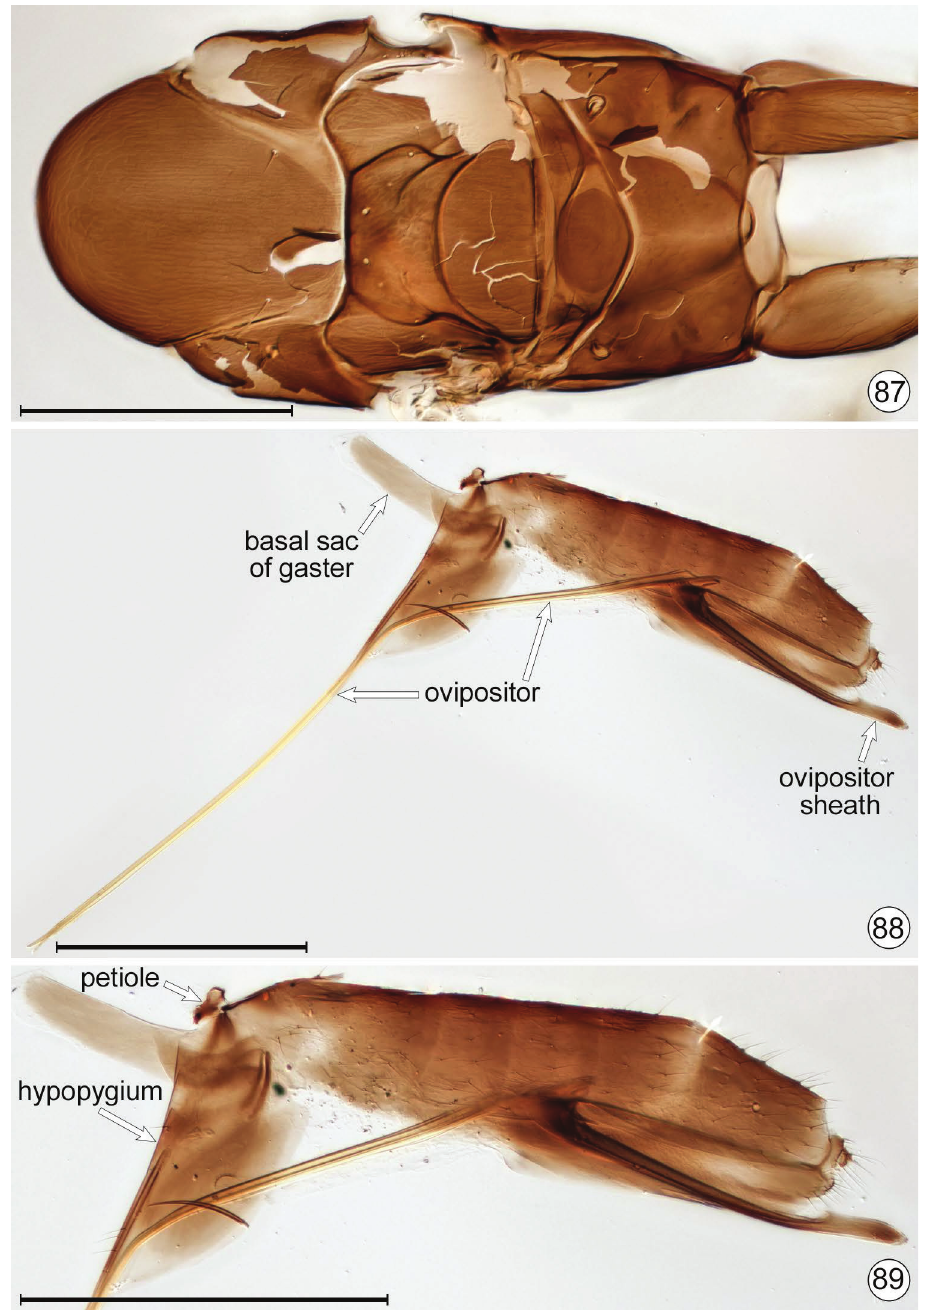
Figures 87–89. Neotriadomerus darlingi , holotype. 87 mesosoma, dorsal 88 metasoma, lateral, with ovipositor unsheathed 89 metasoma enlarged, lateral. Scale bar for 87 = 200 μm; 88, 89 = 500 μm. Note: 88 and 89 are flipped horizontally (gaster apex pointing left in holotype